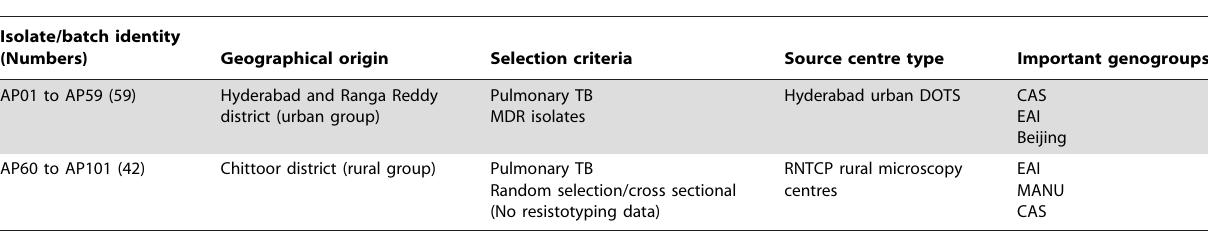
Table 1. Details of the M. tuberculosis isolates studied